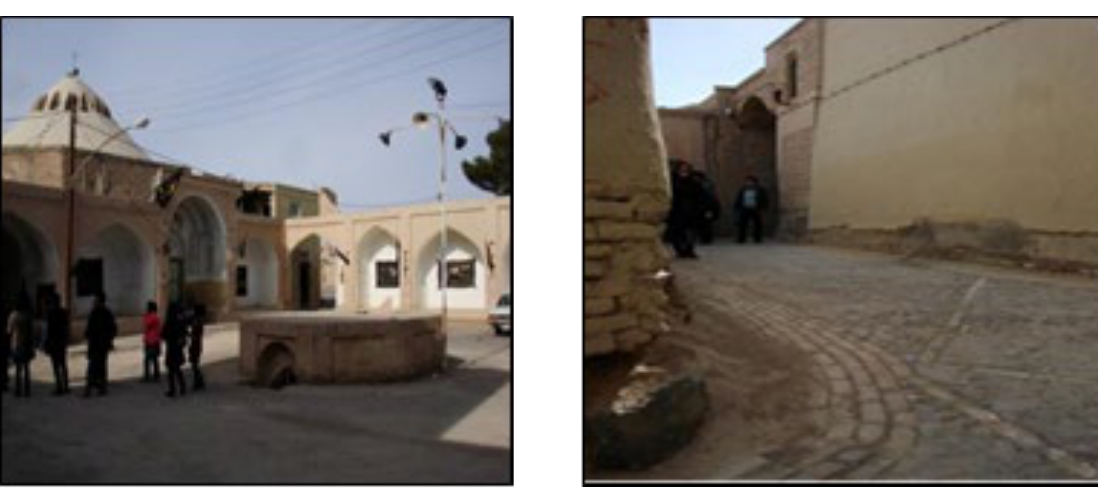
Fig. 11: Regular and geometric interior design and independent wall space